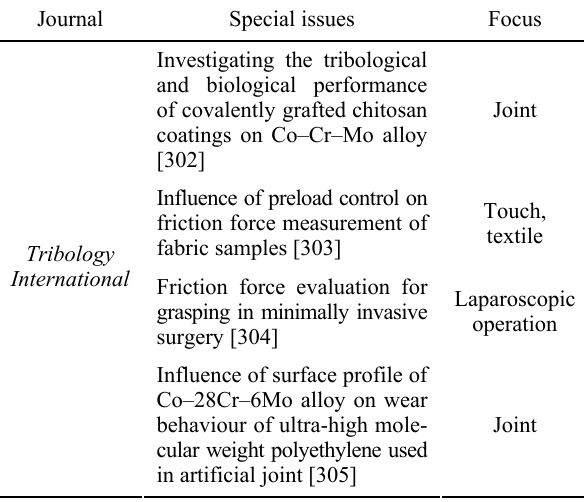
Fig. 19 Number of review papers in different areas. Table 2 Special issues published in Tribology International